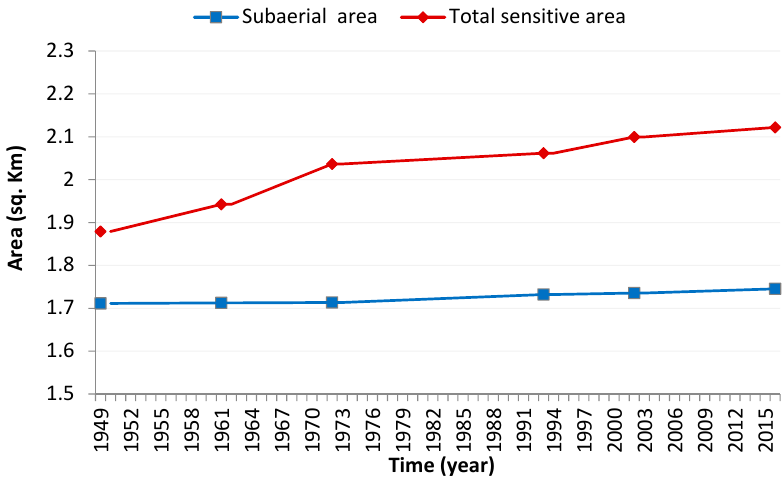
* Sources: Figure 6 and the calculate geometry tool of the data management package in ArcGIS, (after [15,33]).